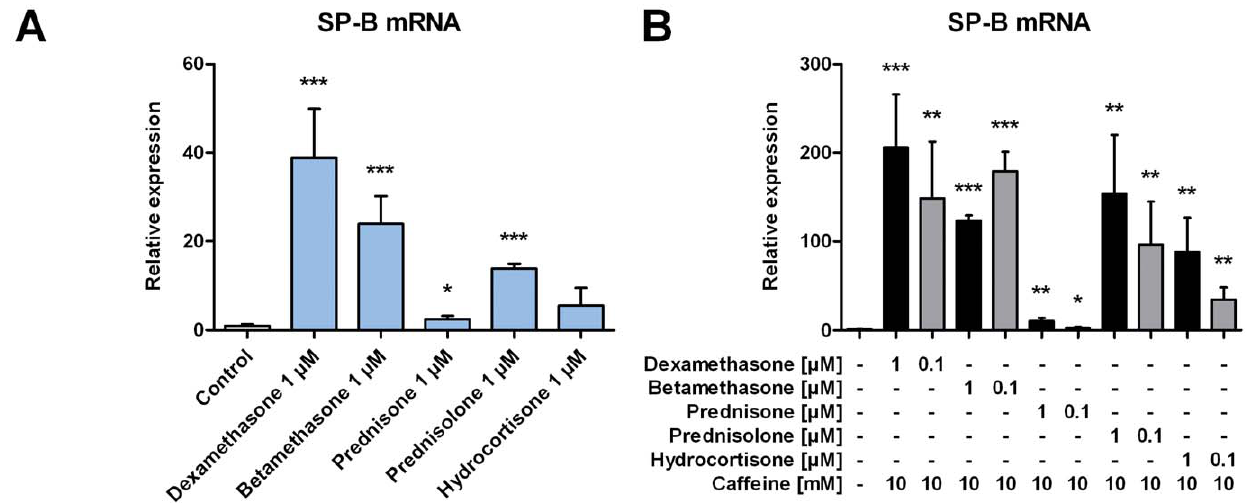
Figure 2. Synergistic effect of caffeine and different glucocorticoids on expression of SP-B mRNA in H441 cells. H441 cells were treated with dexamethasone, betamethasone, prednisone, prednisolone, or hydrocortisone alone ( A ) or in different concentrations in combination with caffeine ( B ). After 24 h qPCR of SP-B mRNA was performed. SP-B mRNA levels were normalized to b -actin, and fold differences compared to untreated cells were calculated. Means 6 SD of at least n=3 independent experiments are shown. * p , 0.05, ** p , 0.01 and *** p , 0.001 compared to control cells.